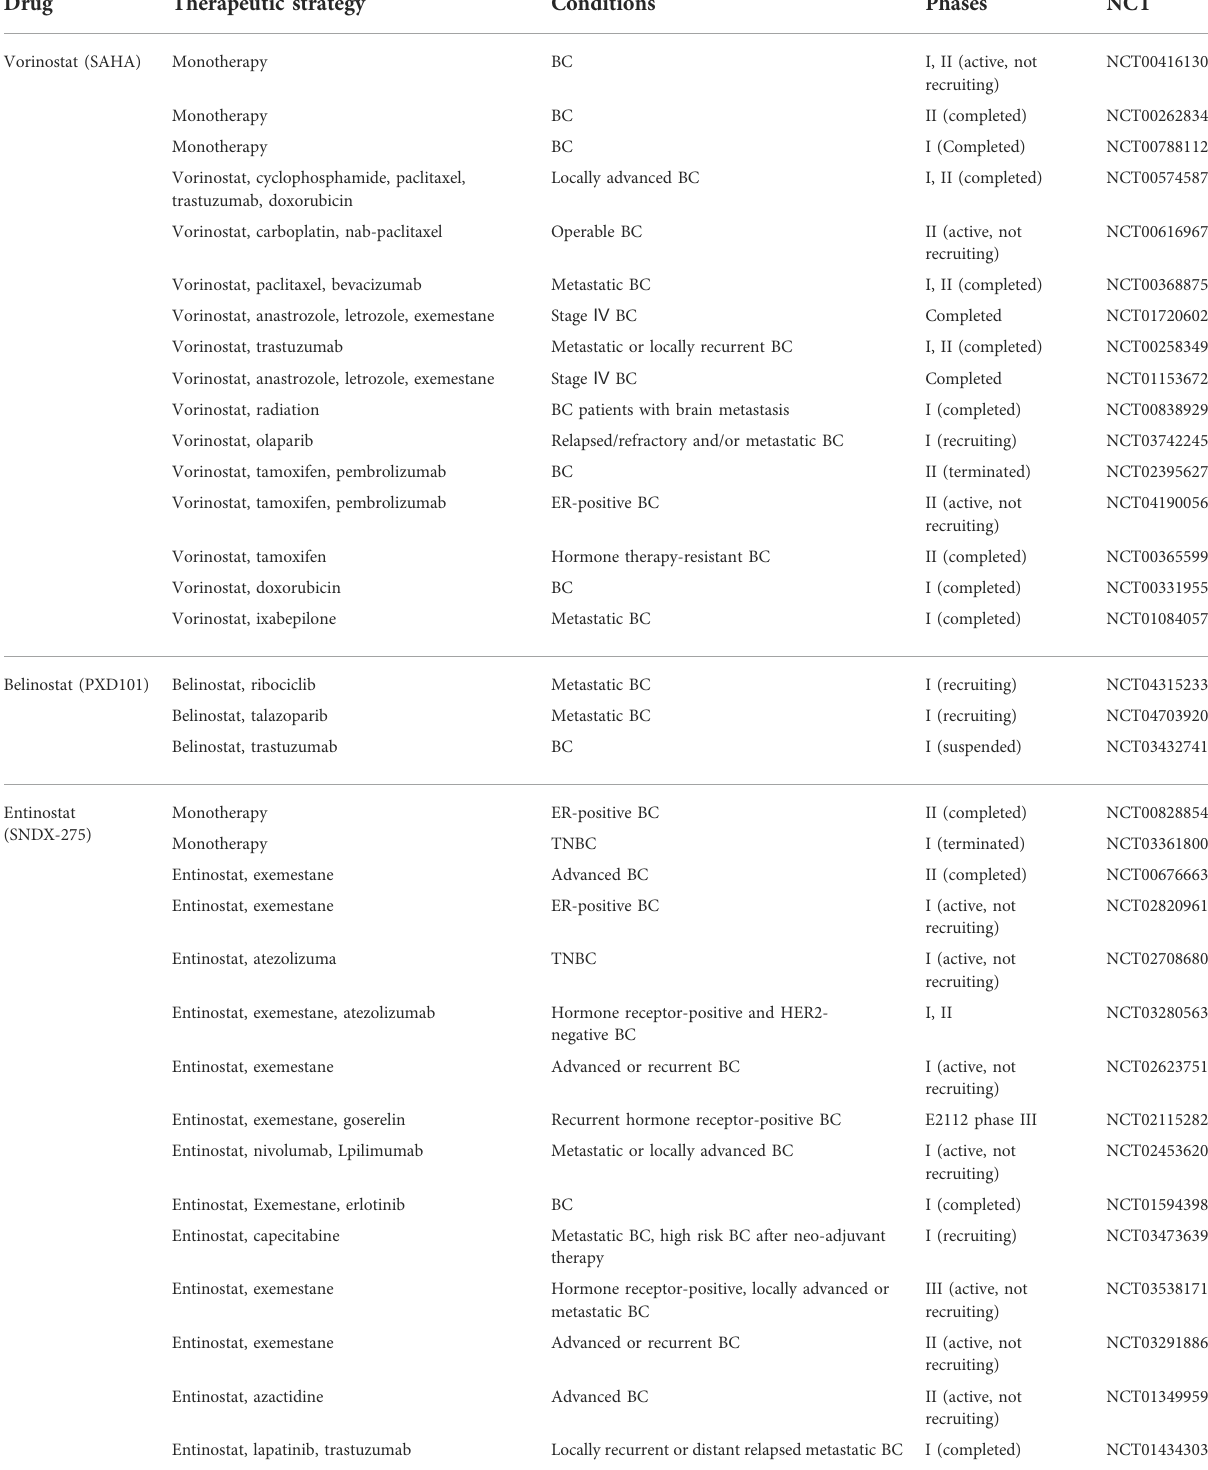
TABLE 4 Summary of HDAC inhibitors on the BC therapeutic strategy and corresponding clinical